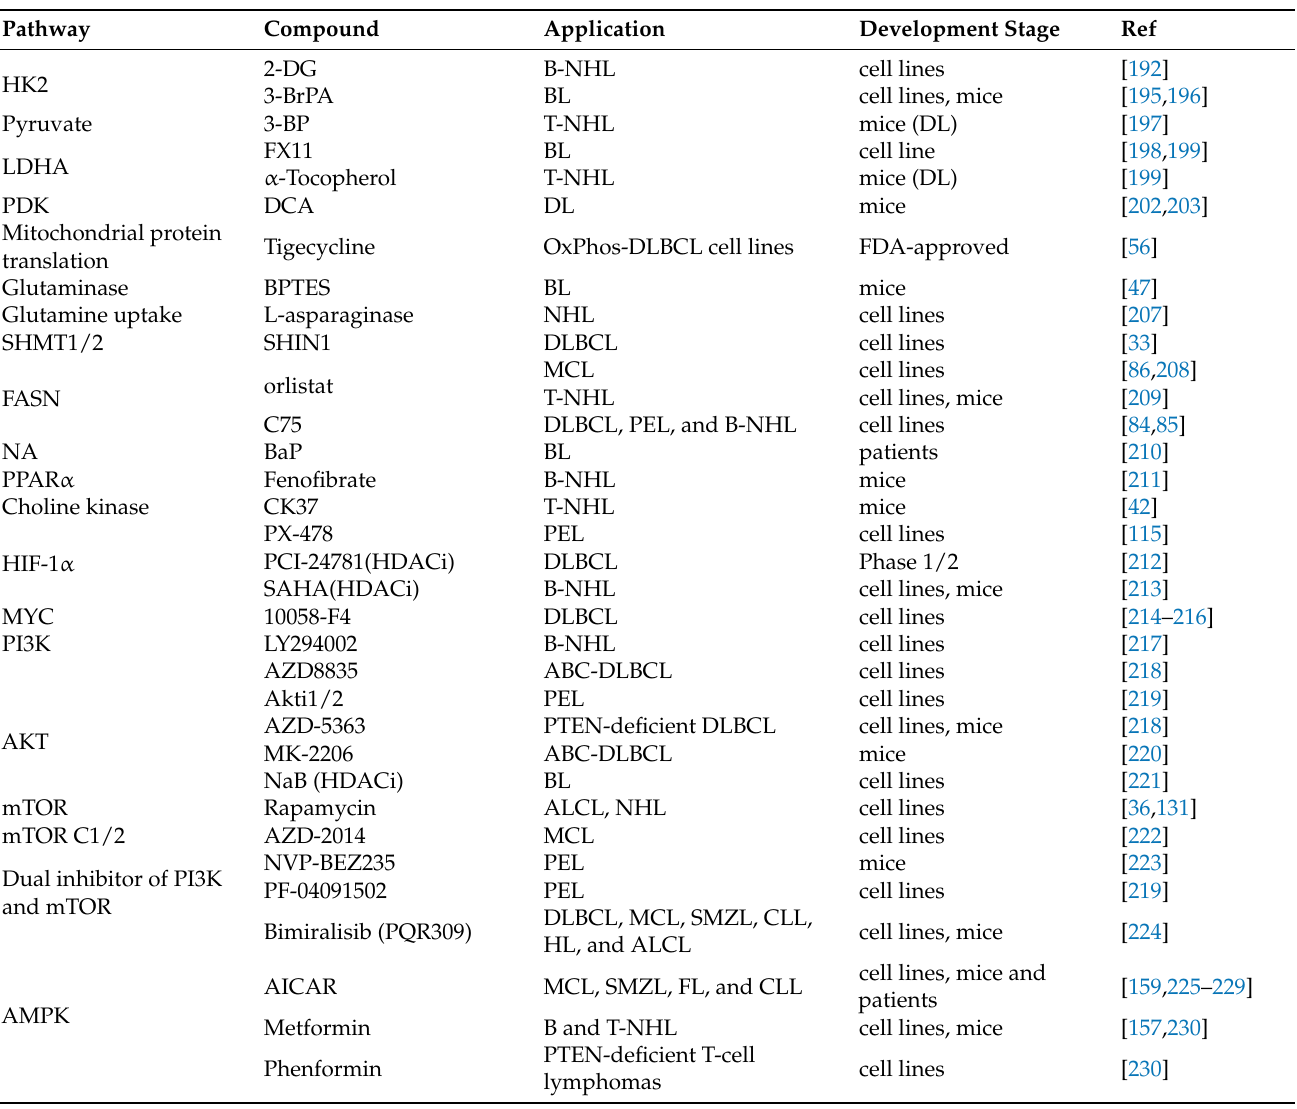
Table 3. Targeting lymphoma metabolism via metabolic enzymes, metabolite depletion, and/or signaling